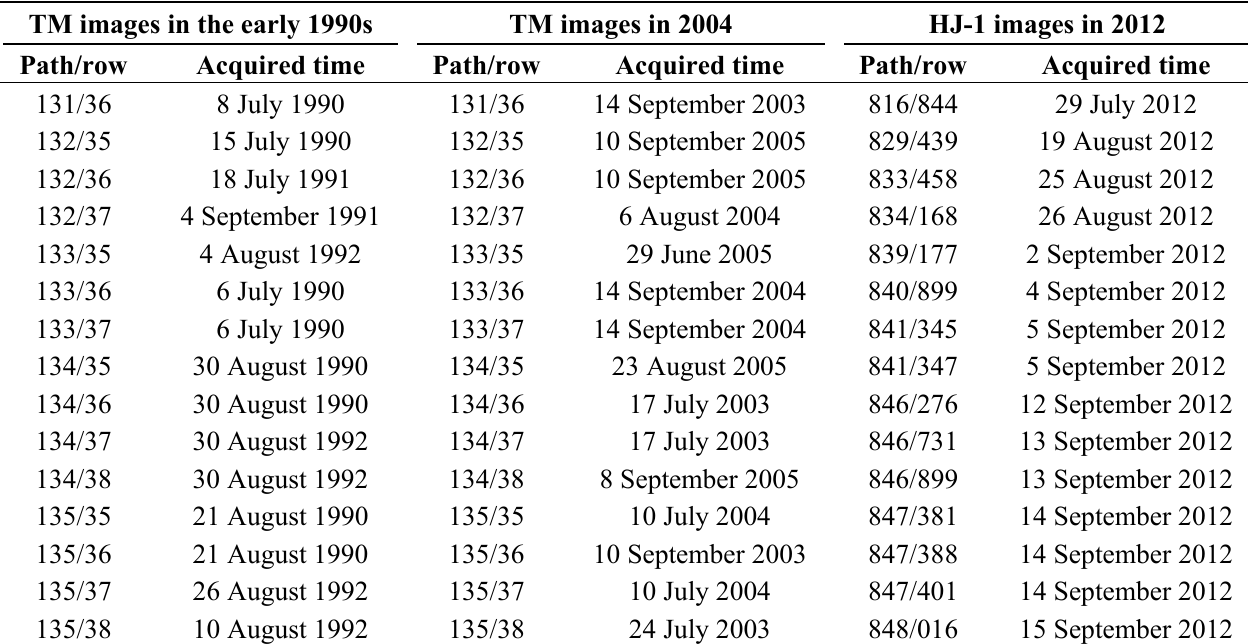
Table A1. The satellite images used to acquire wetland in the TRH region. TM: Thematic